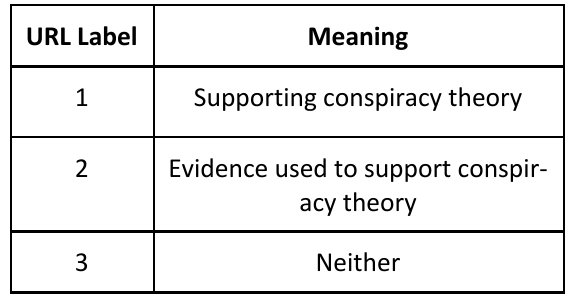
Table 3. Labels used to classify the relation of a URL to conspiracy theories related to the origin of